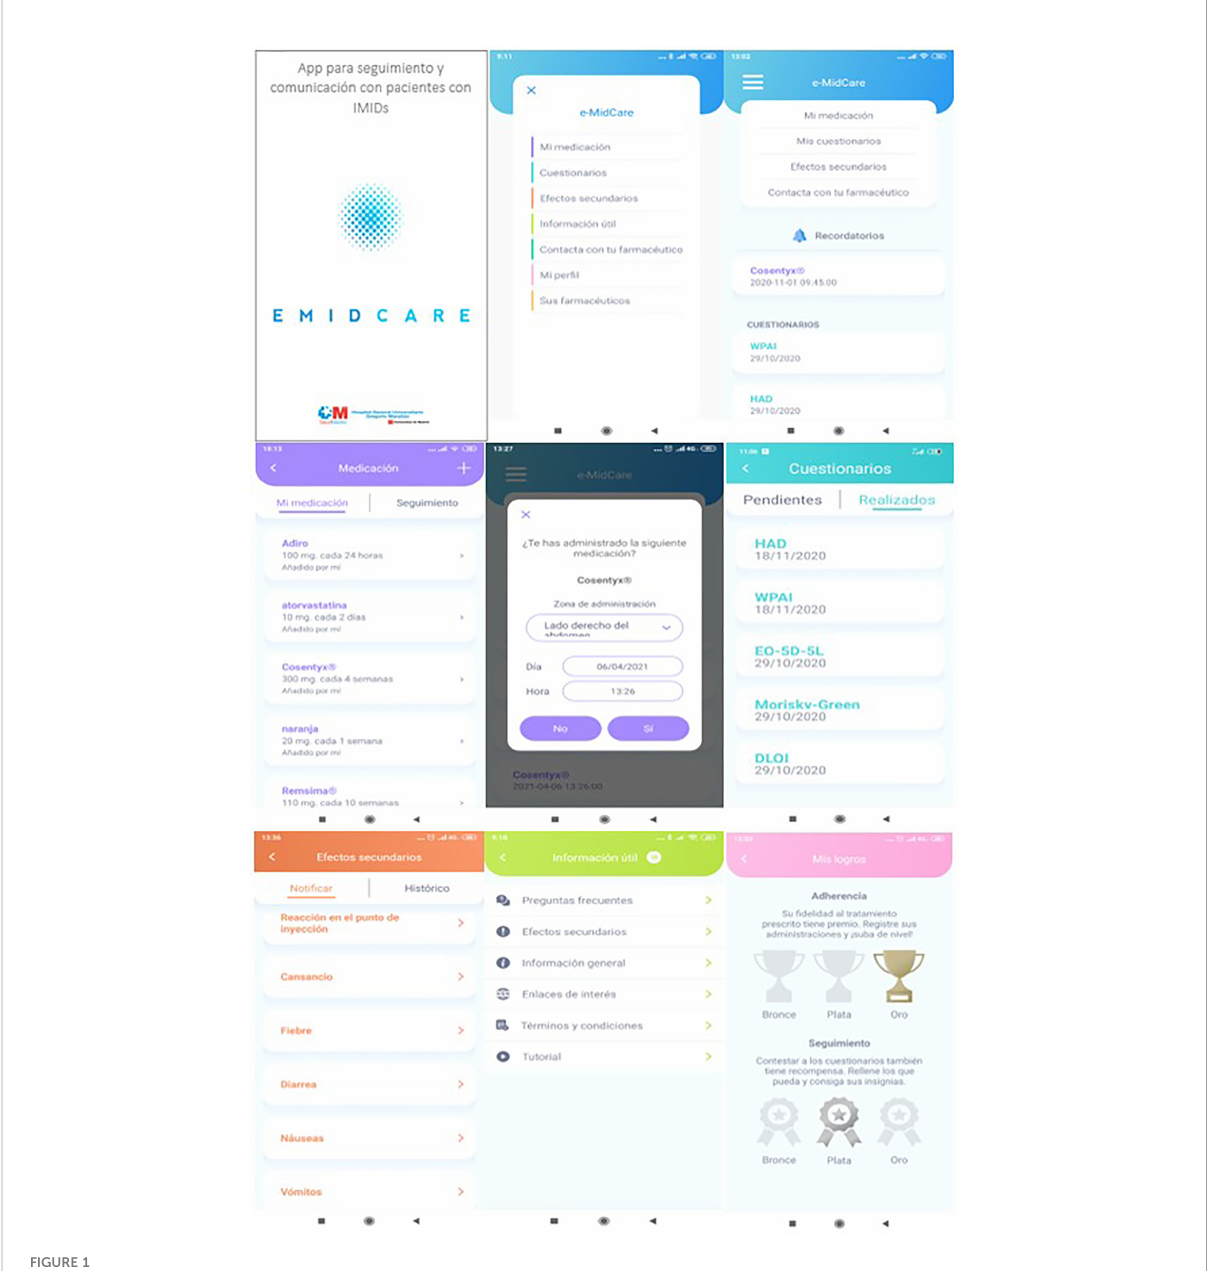
FIGURE 1 Functional diagram of eMidCare ® app